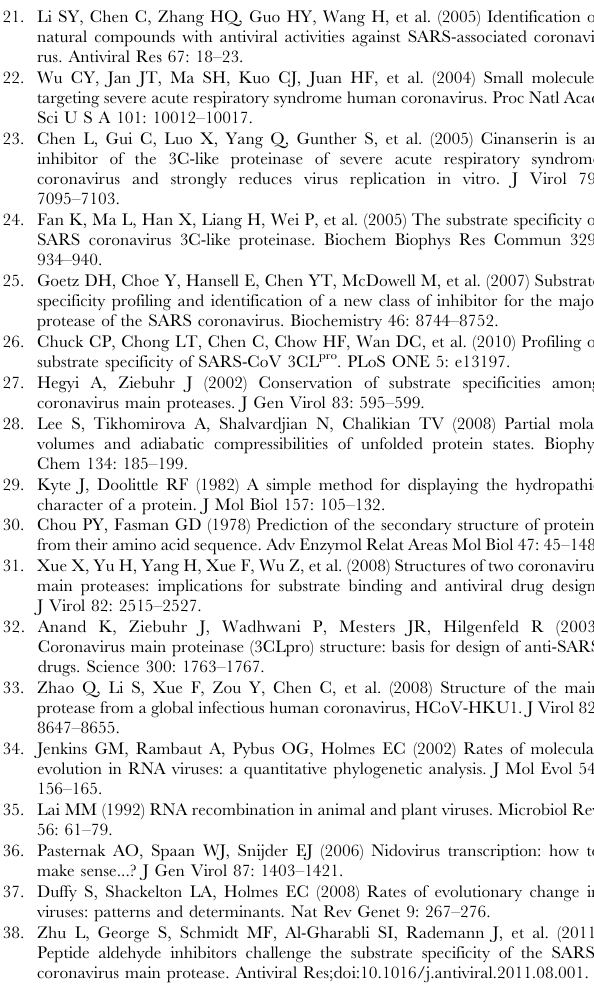
Figure S1 Molecular modeling showing P3-Arg may interact with Glu-166 of 3CL pro . The model was based on the crystal structure of 3CLpro (grey) in complex with a peptide substrate ‘TSAVLQ Q SGFRK’ (yellow). P3-Val was replaced by P3-Arg using the program PyMOL. As shown, the invariant Glu- 166 is in close proximity to P3-Arg, and may form favorable charge-charge interaction to P3-Arg.